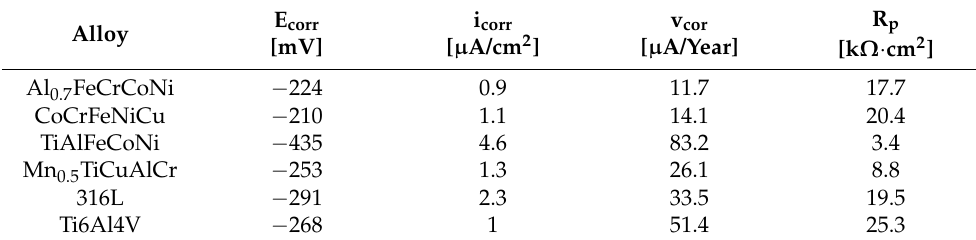
Figure 7. Potentiodynamic curves obtained for the investigated alloys. Table 7. Selected corrosion parameters of the investigated Table 7. Selected corrosion parameters of the investigated materials.